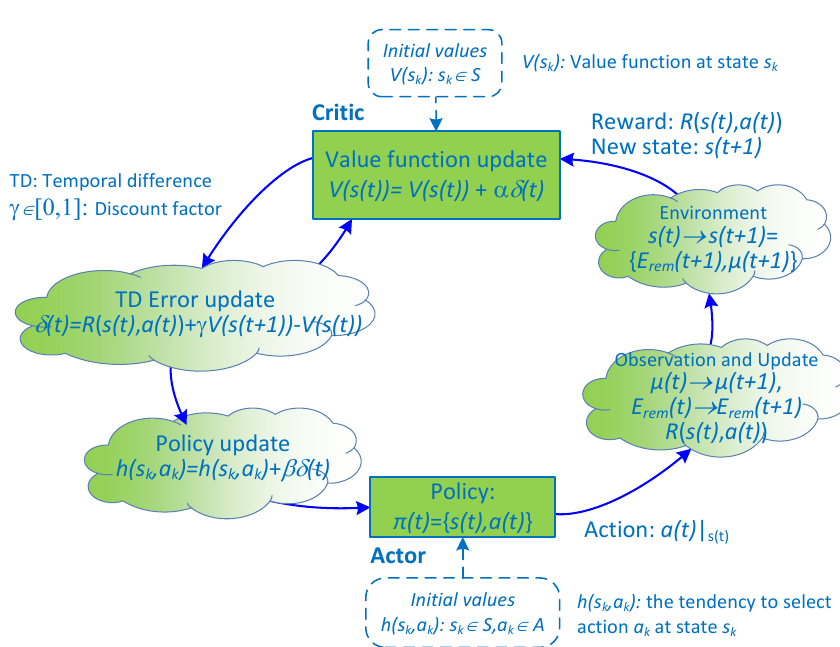
Figure 7. The actor–critic learning process of the proposed